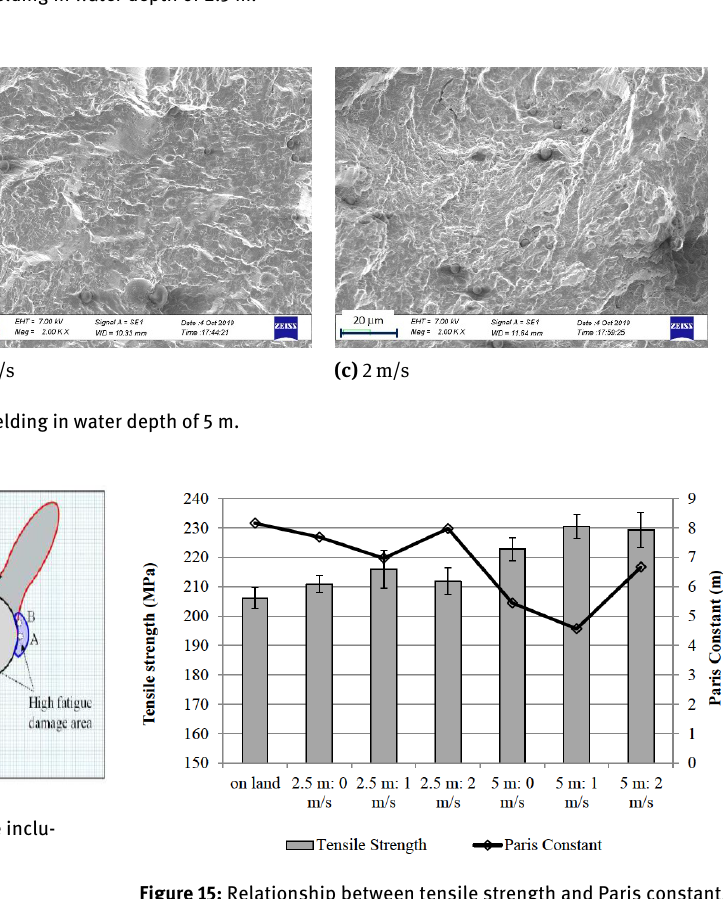
Figure 12: Fatigue fracture surface of underwater wet welding in water depth of 2.5 m.